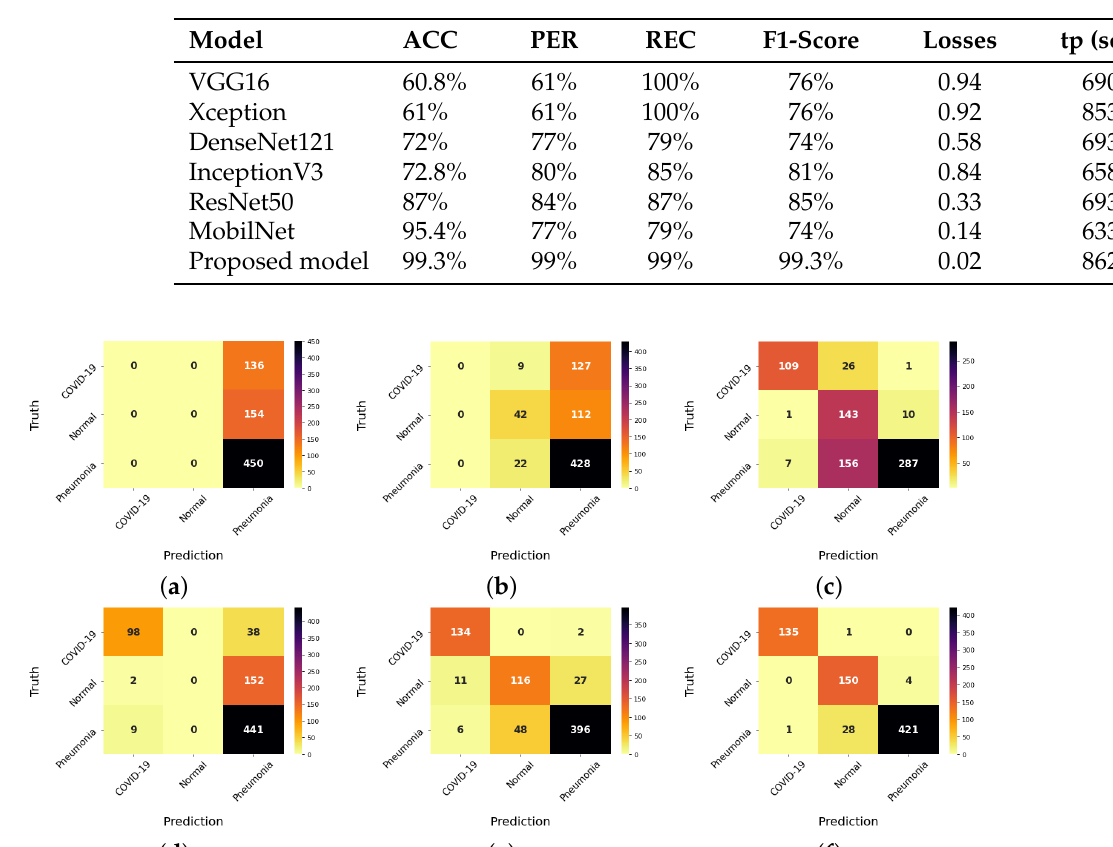
Table 6. Comparative accuracy of our model with other CNN models. Learning rate η = 0.1, ReLU activation function, and Adam optimizer for all pre-trained models.